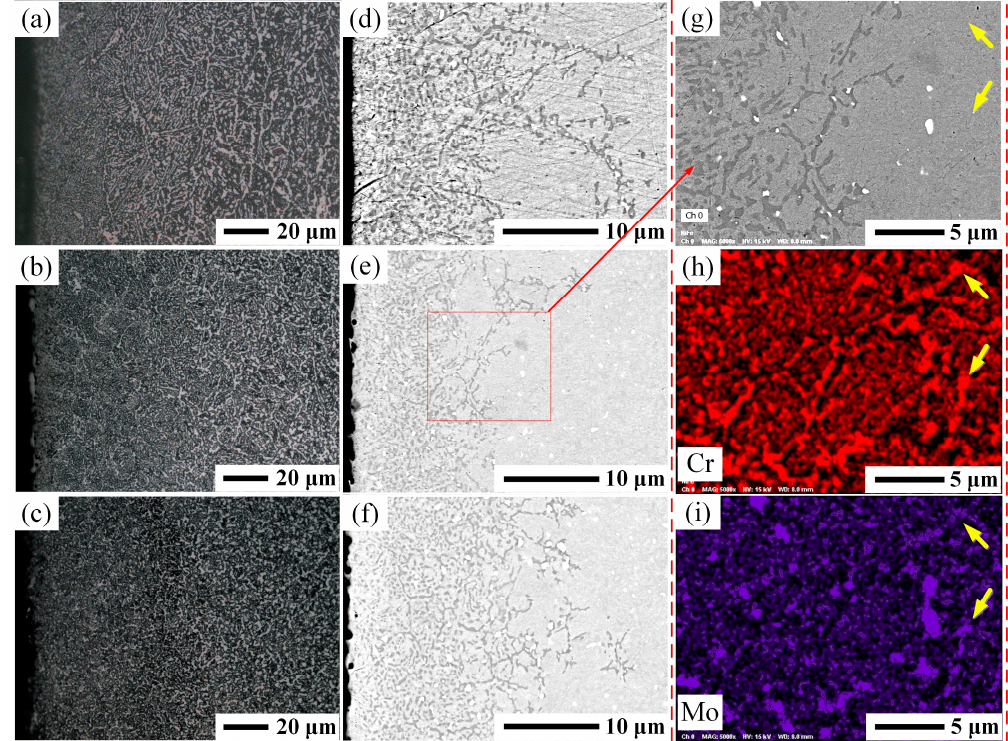
Figure 3. The cross-sectional metallographic pictures of the as-carburized layers: ( a ) uncoated sample, ( b ) sample coated 1.4 μ m Fe–Ni film, and ( c ) sample coated 6.0 μ m Fe–Ni film; the cross-sectional backscattered electron images of the as-carburized layers: ( d ) uncoated sample, ( e ) sample coated 1.4 μ m Fe–Ni film, ( f ) sample coated 6.0 μ m Fe–Ni film, and ( g ) magnified image of the marked area in ( e ); EDS elements map: ( h ) Cr and ( i ) Mo. The arrows indicate the M 23 C 6 carbides, which are low-contrast in the backscatter electron image in unetched condition.